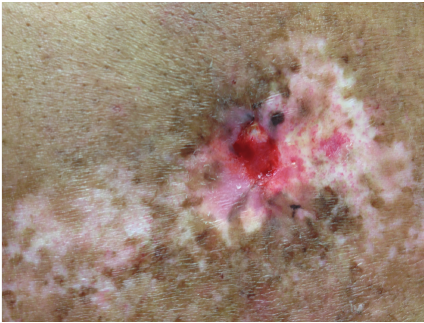
Figure 3: Hematoxylin and eosin, 10X. Epidermis with acanthosis and superficial prominent telangiectasia, with fibrin and fibrosis.